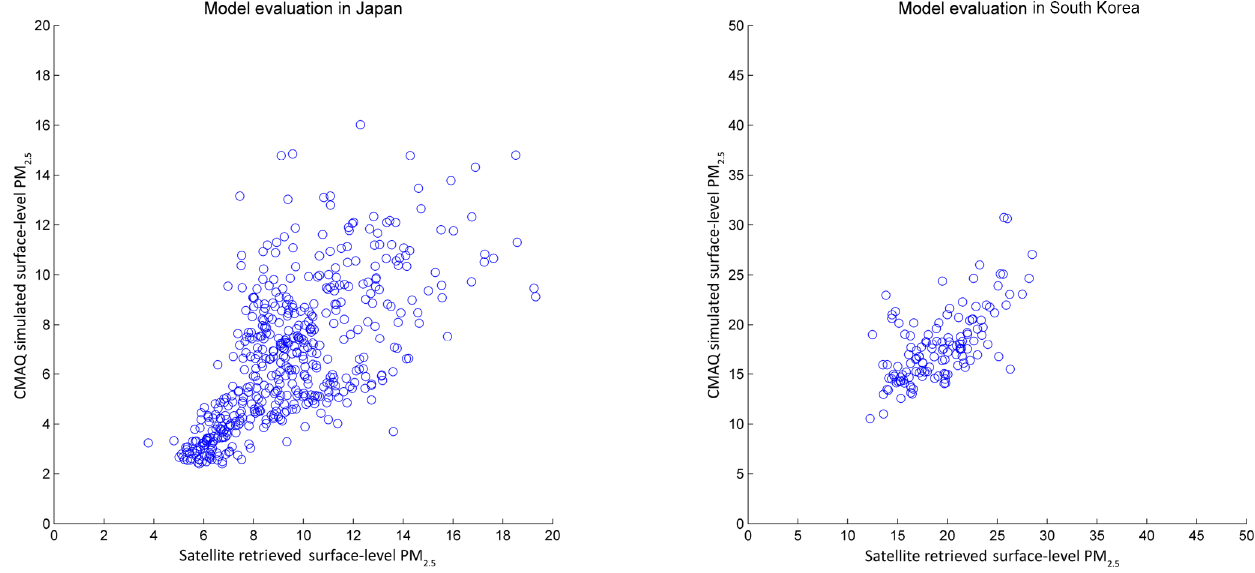
Figure 2. Model evaluation using satellite-retrieval PM 2 . 5 over Japan and South Korea. Table 4. Model evaluation of acid deposition in Japan and South Korea. NMB refers to the normalized mean bias, RMSE refers to root mean square error, and IoA refers to index of